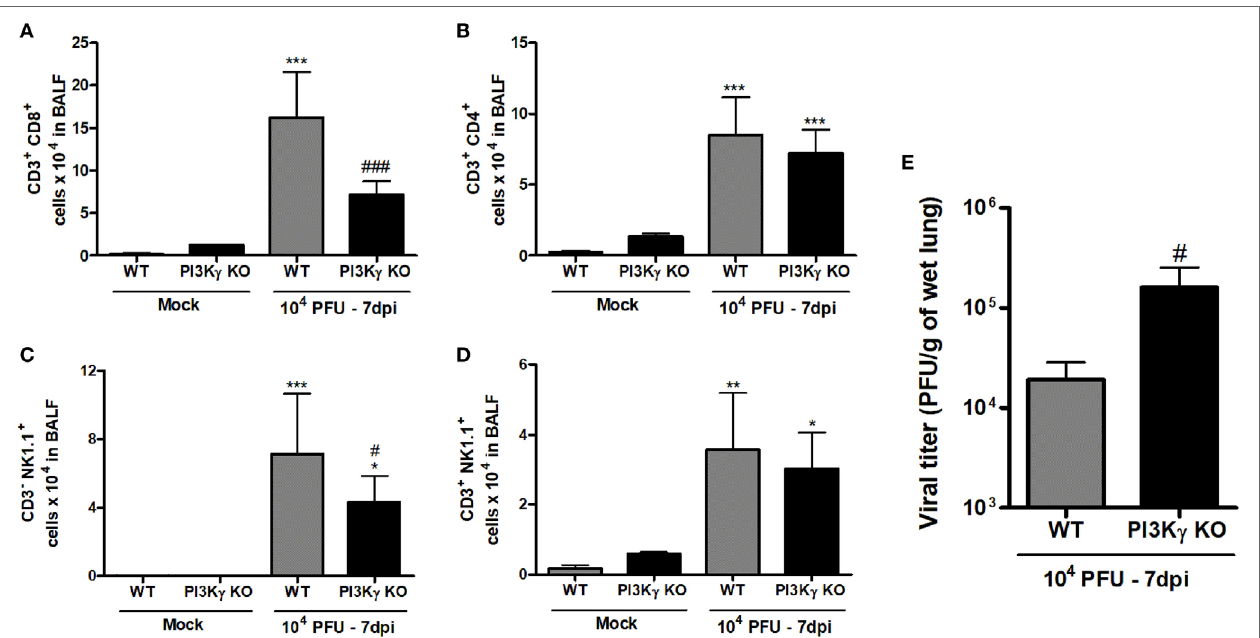
FigUre 6 | Late lymphocyte infiltration and viral control in lungs of WT and phosphatidyl inositol 3 kinase-gamma (PI3K γ ) knockout (KO) after influenza A virus infection. WT and PI3K γ KO mice were inoculated with 10 4 plaque-forming units (PFU) of influenza WSN or phosphate-buffered saline and killed after 7 days (representative of two experiments showing n = 4–7 mice per group). Number of (a) CD8 + T cells (CD3 + CD8 + ), (B) CD4 + T cells (CD3 + CD4 + ), (c) natural killer (NK) cells (CD3 − NK1.1 + ), and (D) NKT cells (CD3 + NK1.1 + ) were evaluated in bronchoalveolar lavage fluid (BALF) by flow cytometry. (e) Viral levels in lungs, assessed by plaque assay in Madin–Darby Canine Kidney cells. Results are presented as mean ± SD. * p < 0.05, ** p < 0.01, and *** p < 0.001, when compared with Mock groups; # p < 0.05 and ### p < 0.001, comparing KO to WT-infected mice [ (a–D) one-way ANOVA, Newman–Keuls; (e) t